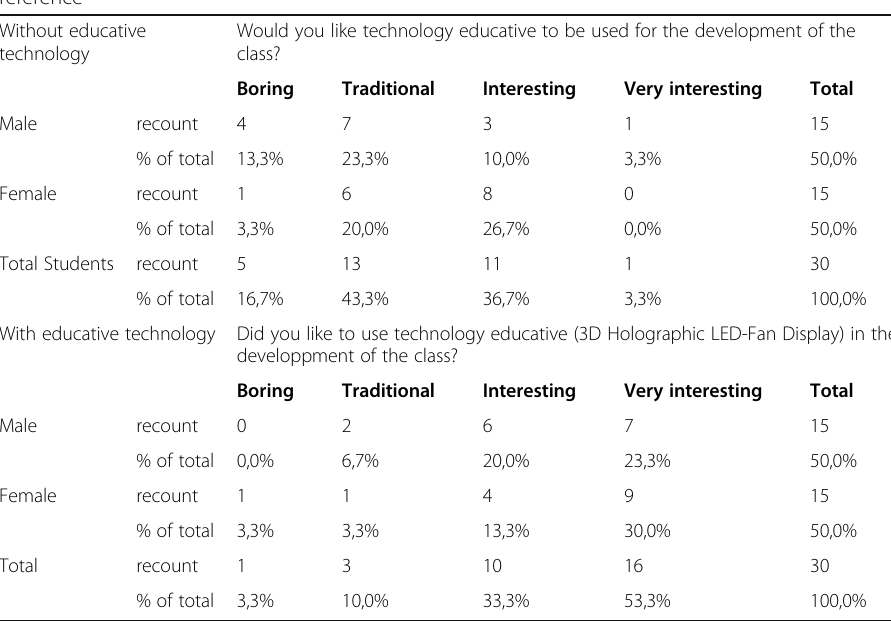
Table 4 Comparative pre and post- questionnaire about educative technology in class. Cross reference